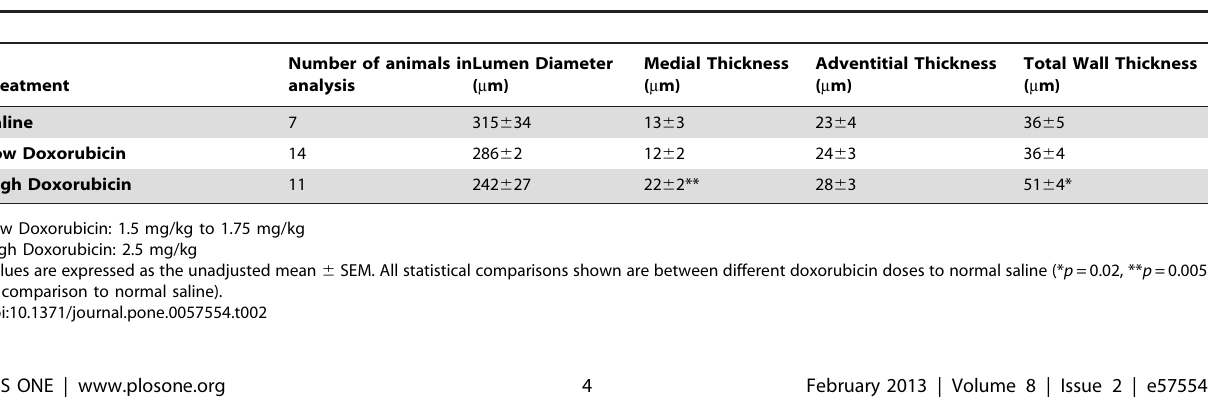
Table 2. Effect of Doxorubicin (DOX) on coronary artery lumen diameter, medial thickness, adventitial thickness and total wall